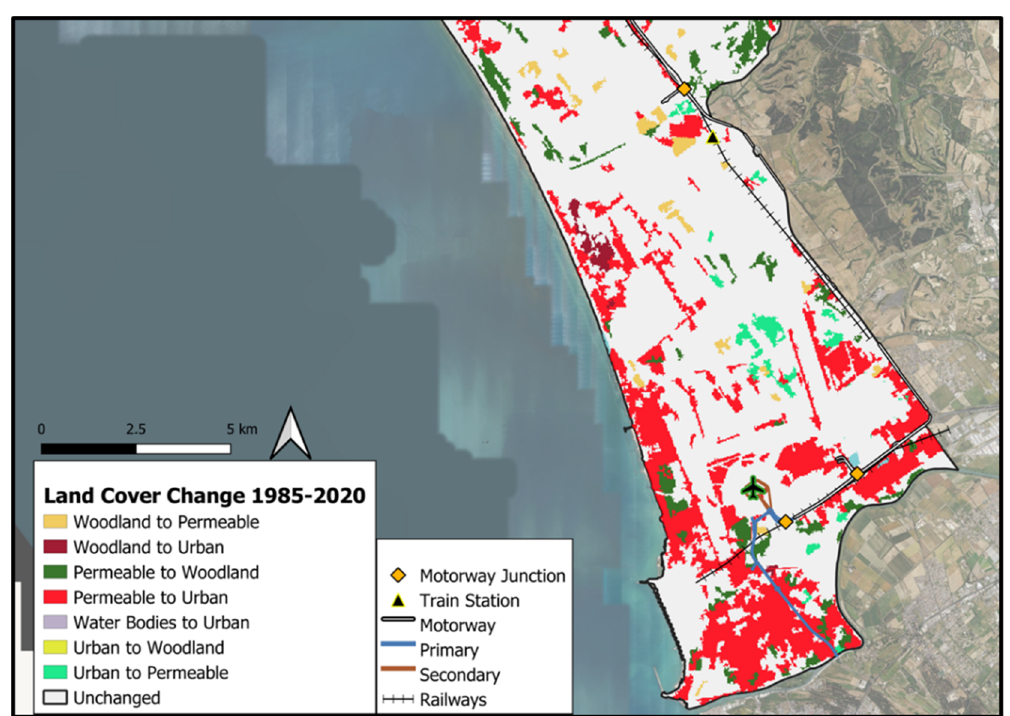
Figure 11. Variation and dynamics of LC within the Fiumicino municipality for the total time span (1985 ÷ 2020), sieved image at a threshold of 5 pixels, 4-bit connectivity.